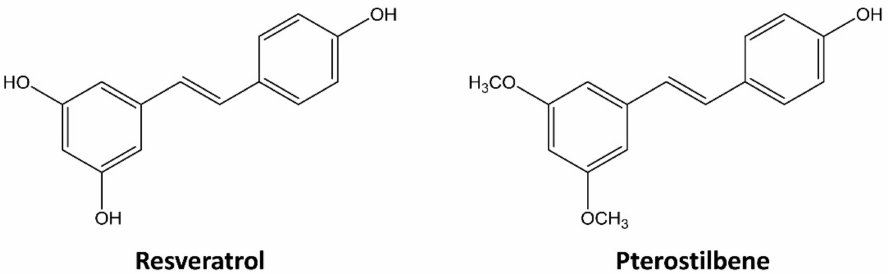
Figure 1. Chemical structures of resveratrol and